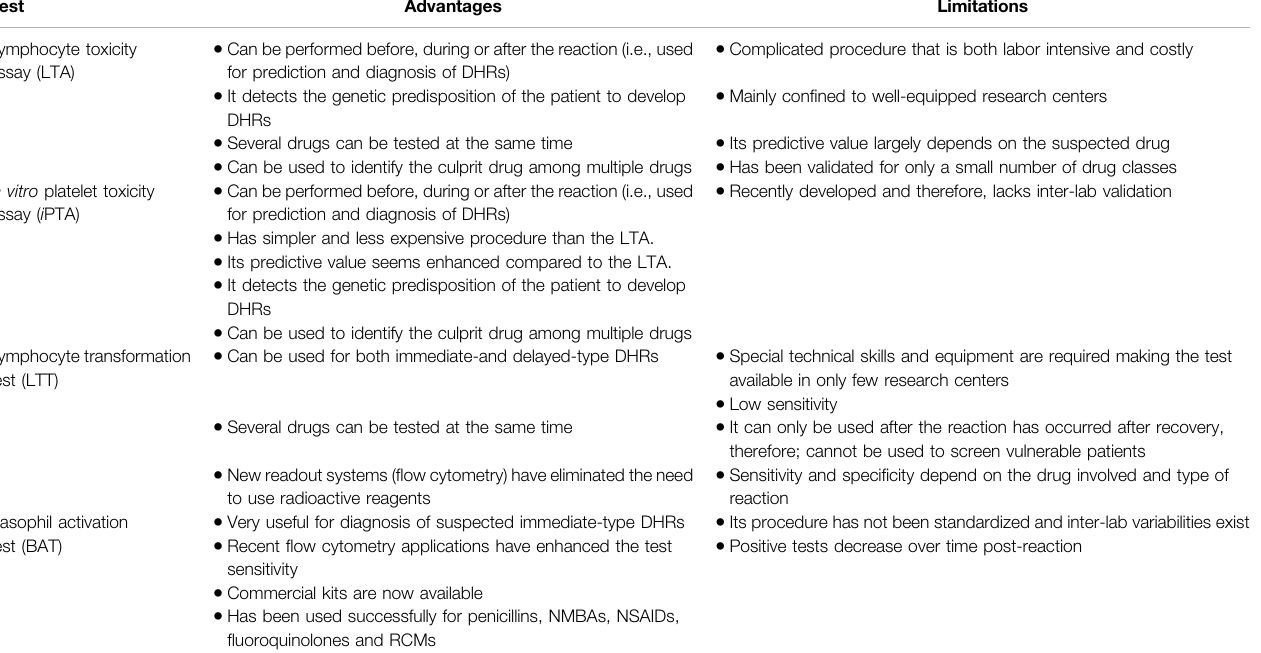
TABLE 2 | In vitro test used for DHRs and their advantages and limitations. Test Advantages Limitations